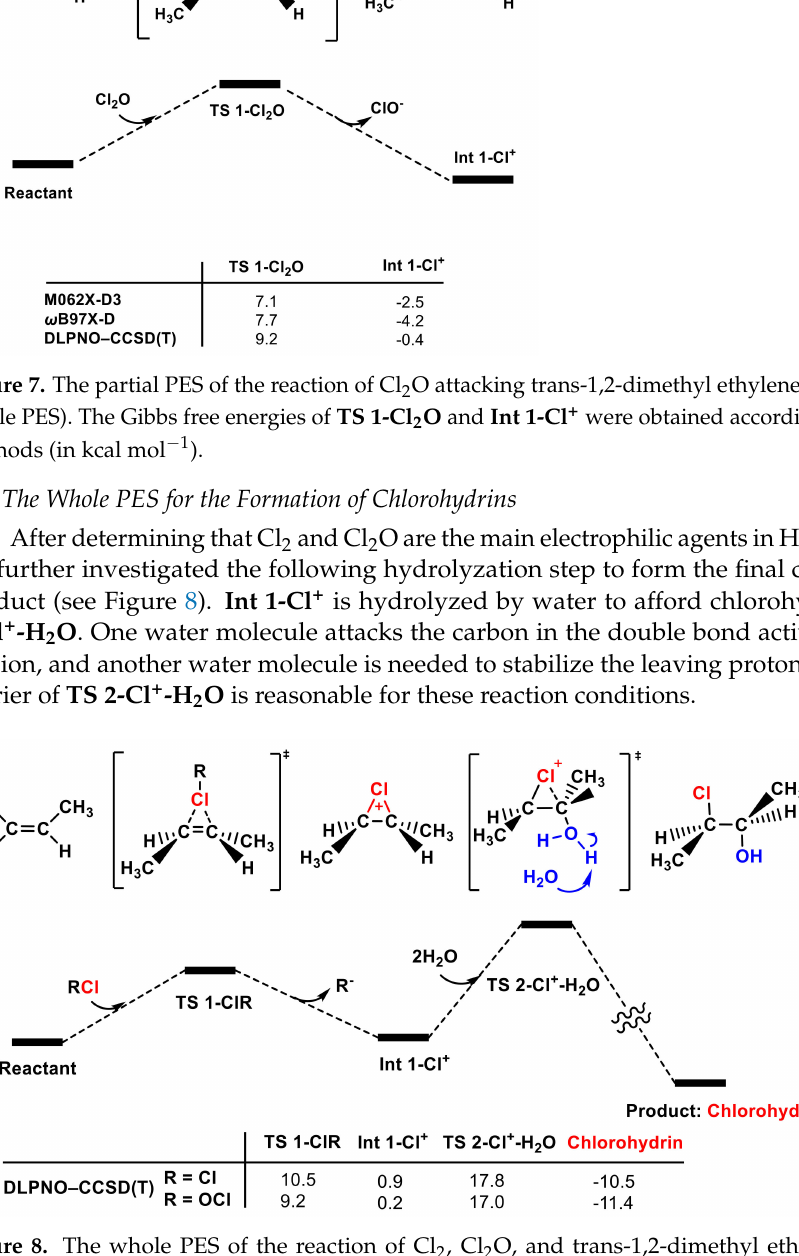
Figure 8. The whole PES of the reaction of Cl 2 , Cl 2 O, and trans-1,2-dimethyl ethylene to form chlorohydrins was calculated with the DPLNO-CCSD(T) method (in kcal mol − 1